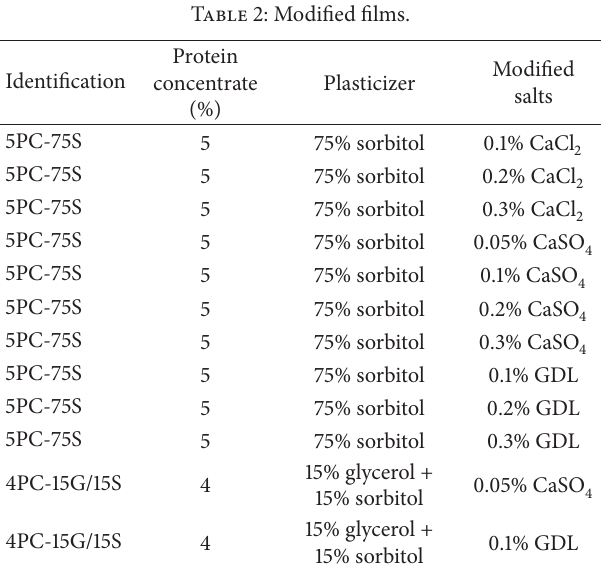
Table 2: Modified